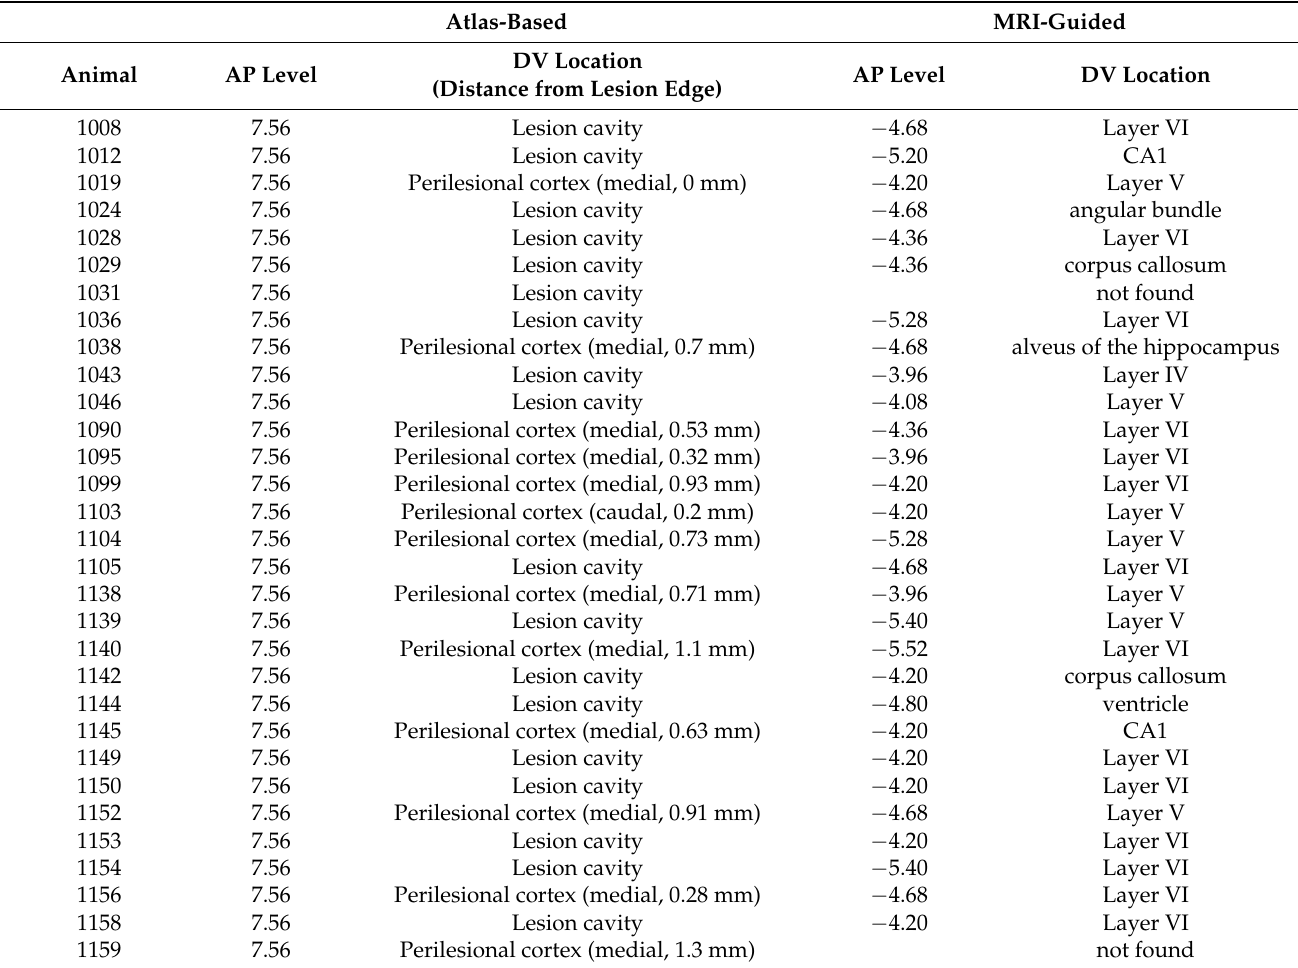
Table 2. Location of the “virtual electrode”. Summary of the locations of the posterior intracortical electrodes in the MRI cohort, if implanted according to the atlas-based coordinates. Note that 58% (18/31) of the lower electrode tips were in the cortex while 42% (13/31) of the lower tips were in the lesion cavity. After MRI-guidance, 71% (22/31) of the lower tips were recording in the cortex. In 5 additional cases, the upper tip (0.5 dorsal to the lower tip) was expected to record in the cortex, resulting in a total of 87% (27/31) of the electrodes recording in the cortex. Only 1 electrode was not recording in the